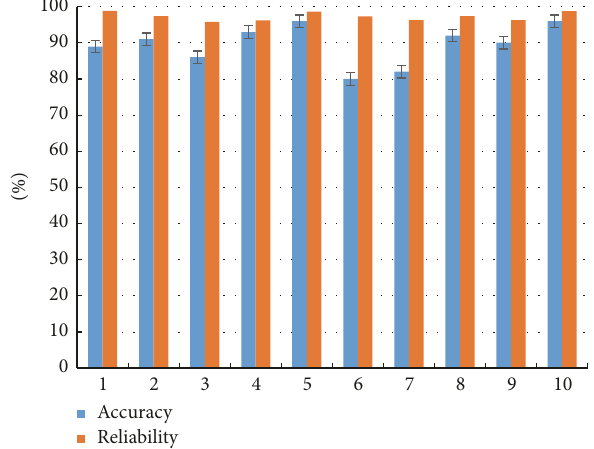
Figure 4: Result of ID3 decision tree (the blue credibility refers to the average accuracy values of 10-fold cross-validation, and the orange credibility refers to the average reliability